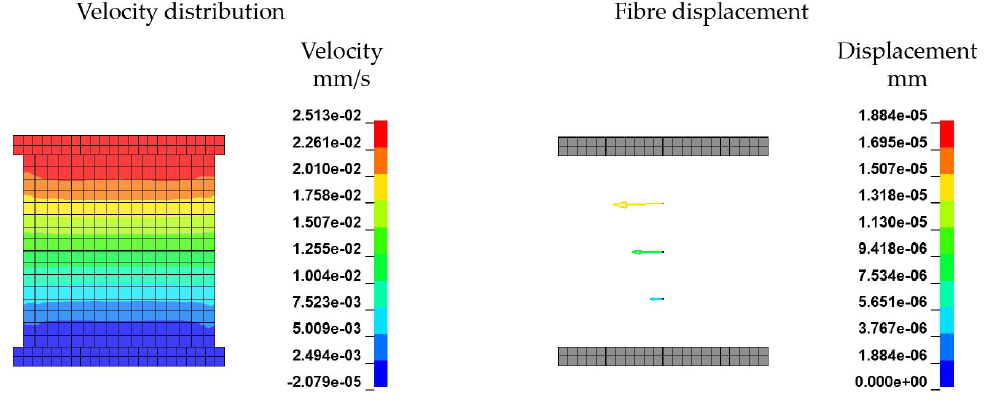
Figure 17. Results of vertical shear